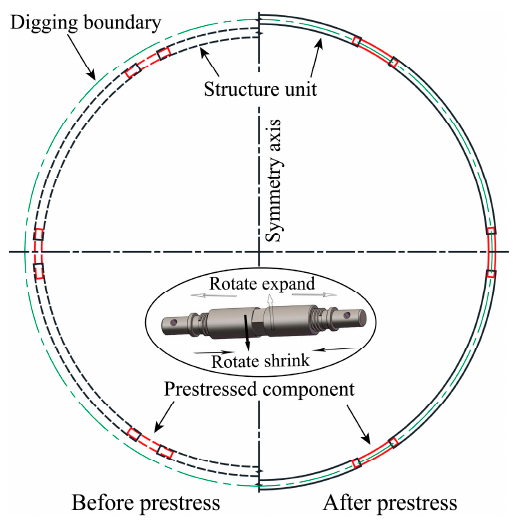
Figure 3. Schematic diagram of the prestress construction.